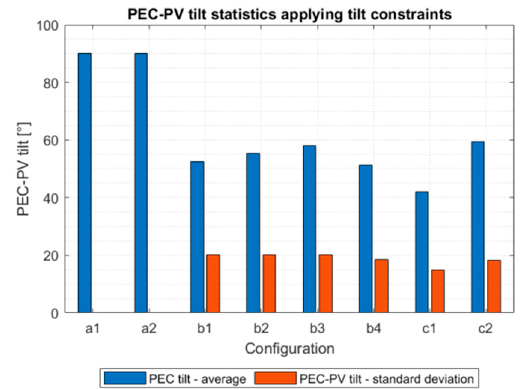
Figure 5. Summary of yearly PEC(-PV) device tilt statistics applying tilt constraints (Figure 1c) for all geometrical configurations listed in Table 5. The yearly average PEC(-PV) tilt is plotted in blue, while the PEC(-PV) tilt yearly standard deviation is plotted in red. Location: Seville, Spain.